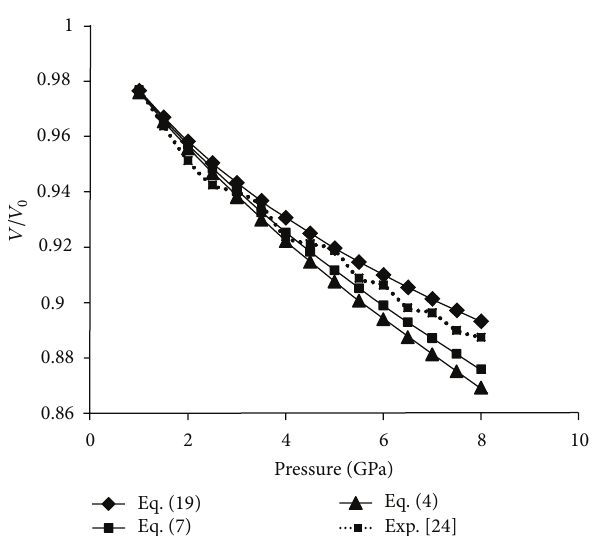
Figure 1: Variation of relative compression ( 𝑉/𝑉 0 ) with pressure for nanotube bundle.